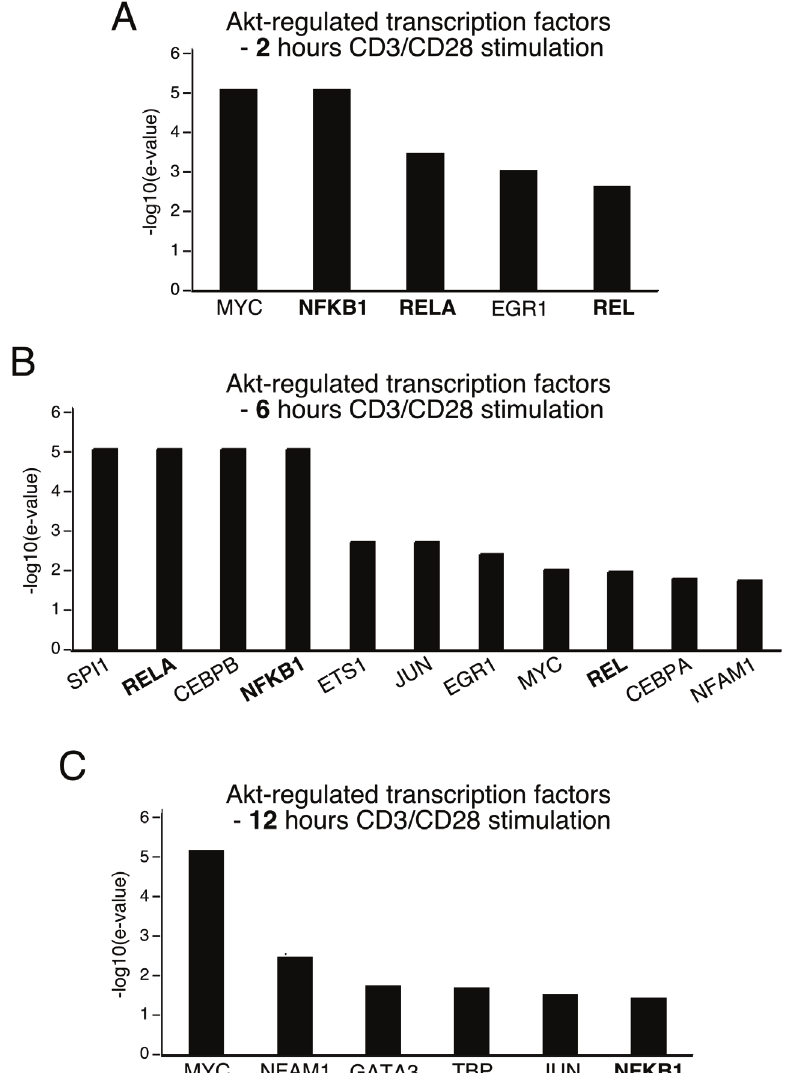
Figure 6. Transcription factor binding sites enriched in Akt-dependent genes, as predicted by TFactS. The list of Akt-dependent genes was submitted to TFactS (sign-less) using default settings. Significance of regulated transcription factors was determined with–log10